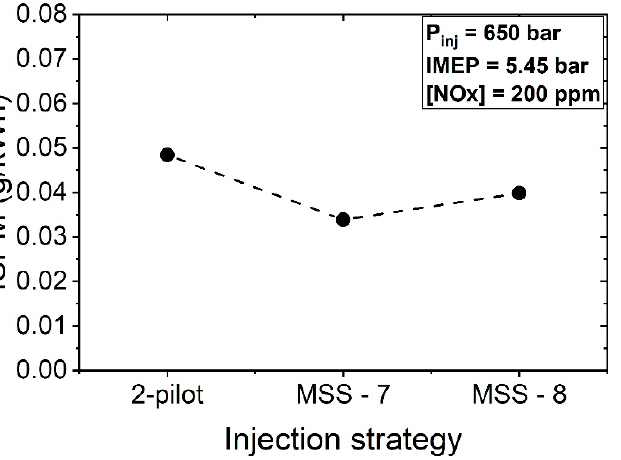
Figure 12. Exhaust emissions of the two-pilot injection strategy and two MSS injection strategies with EGR; ISPM: indicated specific particulate matter.